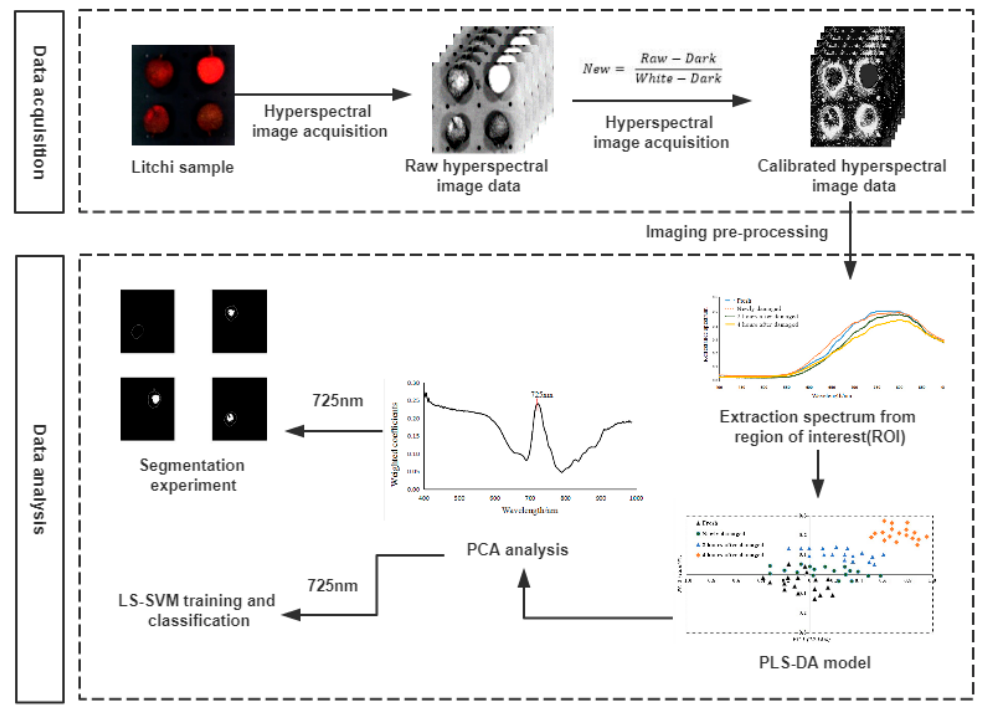
Figure 3. Diagram of the main procedure for analyzing hyperspectral imaging data.